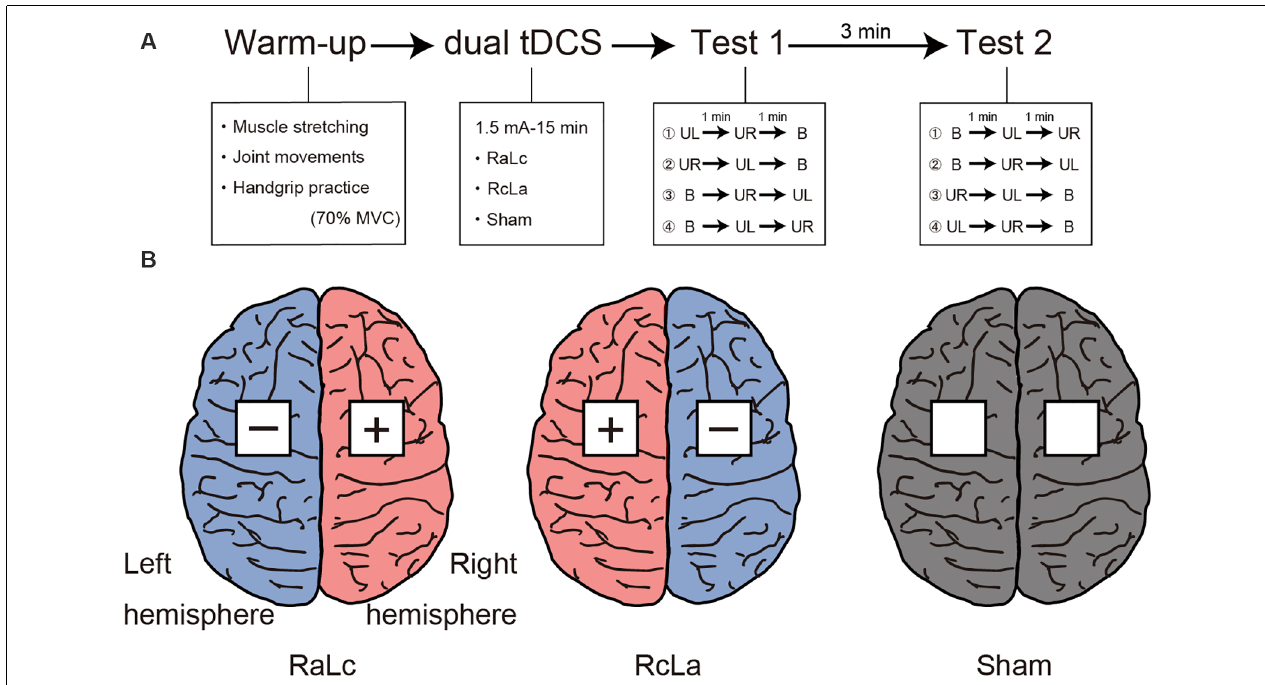
FIGURE 1 | (A) Experimental procedure. Participants first performed a warm-up with muscle stretching, joint movements, and handgrip practice. Subsequently, participants received each bilateral transcranial direct current stimulation (tDCS) applied to the bilateral primary motor cortex (M1) for 15 min. Finally, participants performed Test 1 and Test 2 to measure handgrip strength. MVC, maximal voluntary contraction; UL, unimanual left handgrip; UR, unimanual right handgrip; B, bimanual handgrip. (B) Each tDCS montage left, RaLc, the anode on the right M1 and the cathode on the left M1; middle, RcLa, the anode on the left M1 and cathode on the right M1; right, Sham